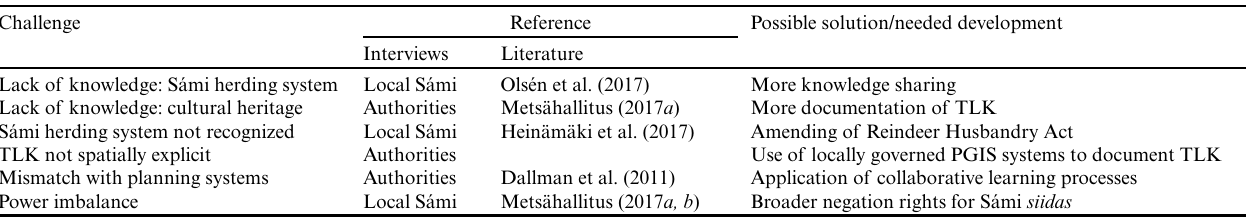
Table 2 . Different challenges in incorporating traditional and local knowledge (TLK) into land use planning and possible